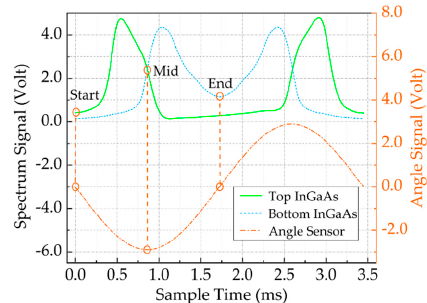
Figure 4. Two full scans within one mirror oscillation and the beginning of the spectrum of the top InGaAs (i.e., 800 – 1650 nm) and the end of the spectrum of the bottom InGaAs (i.e., 1650 – 2500 nm), which both correspond to the position where the angle signal output is 0. Their intersection points correspond to the position where the angle signal output is the largest.